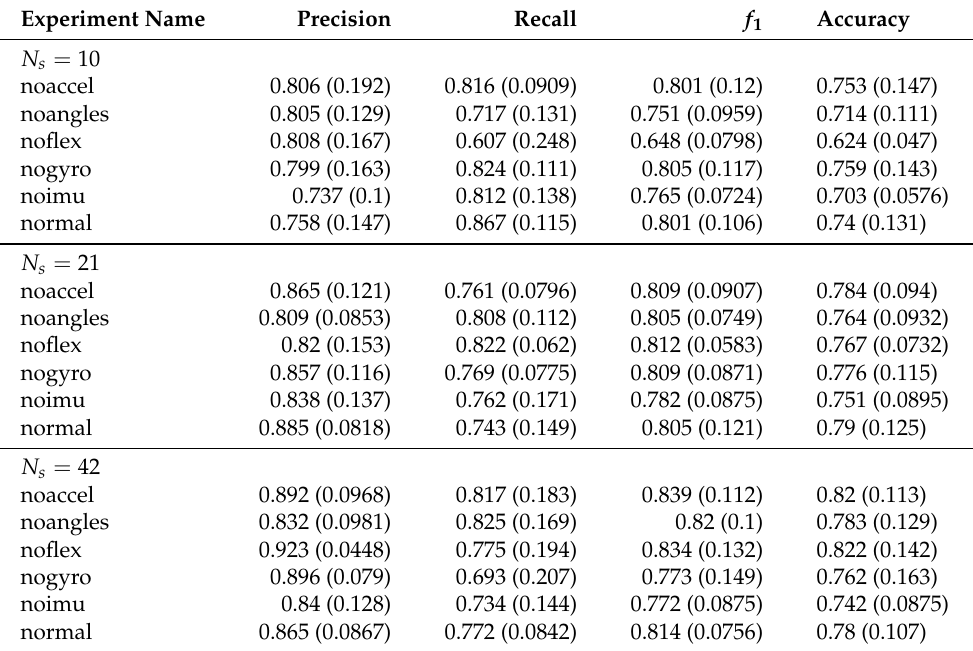
Table A2. Leave-one-out cross validation results for anomaly classification.